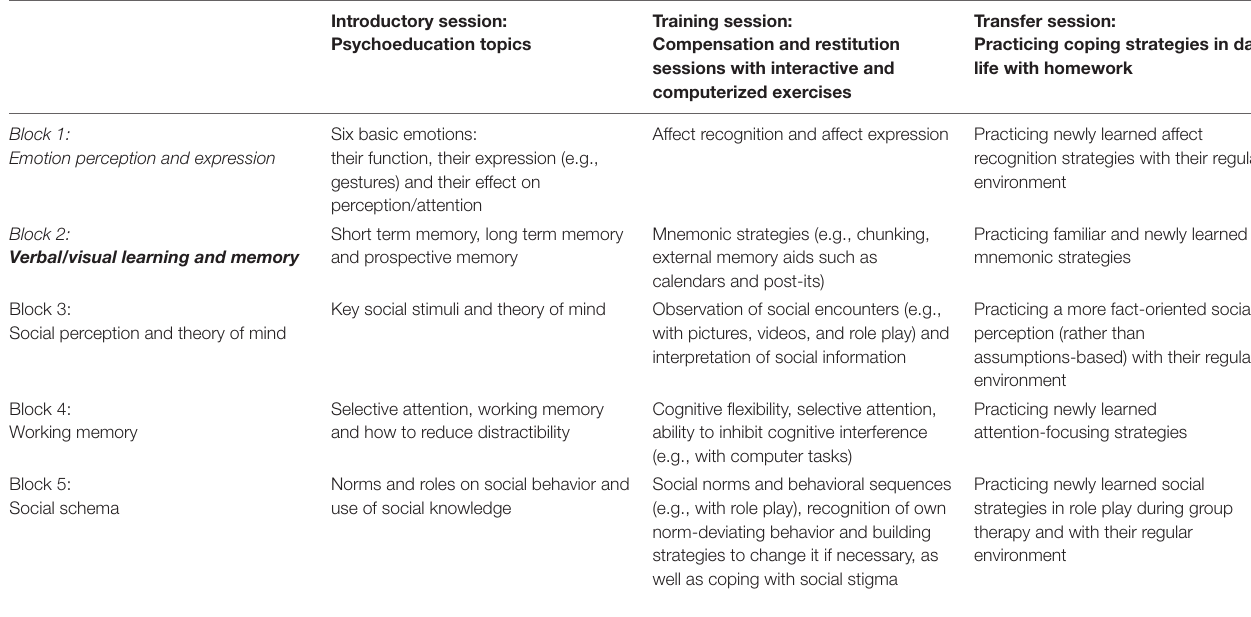
TABLE 2 | SCRT therapy contents a trained cognitive